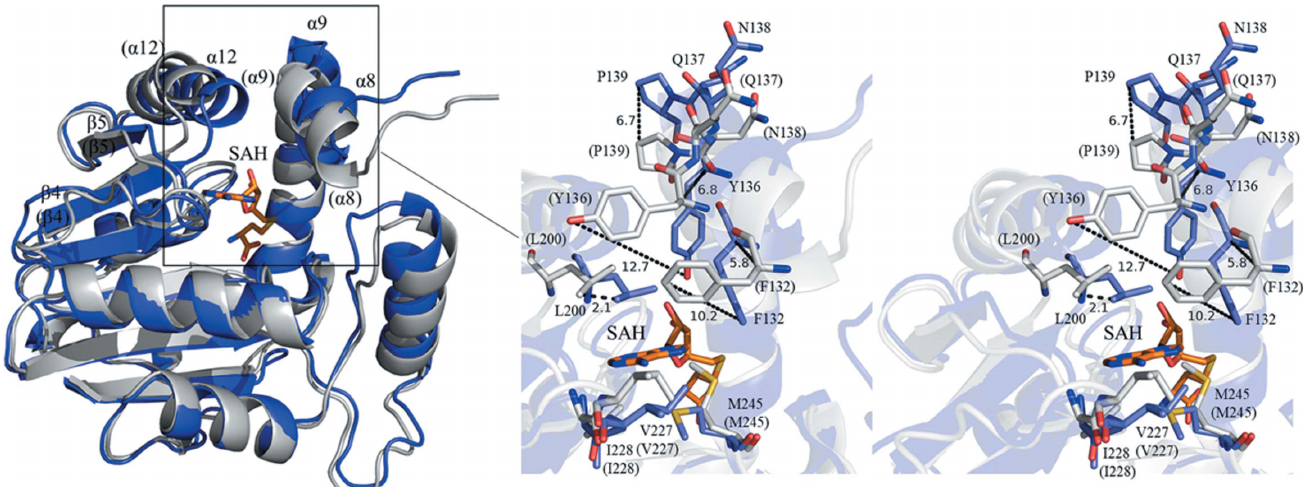
Figure 6 Conformational changes: structure comparison of PigF–SAH and apo PigF. The cartoon and ribbon representation of PigF–SAH is coloured blue, residues of PigF–SAH are coloured blue and labelled in black. The cartoon and ribbon representation of apo PigFis coloured grey, residues are coloured grey and labelled in black in parentheses. SAH is shown as orange